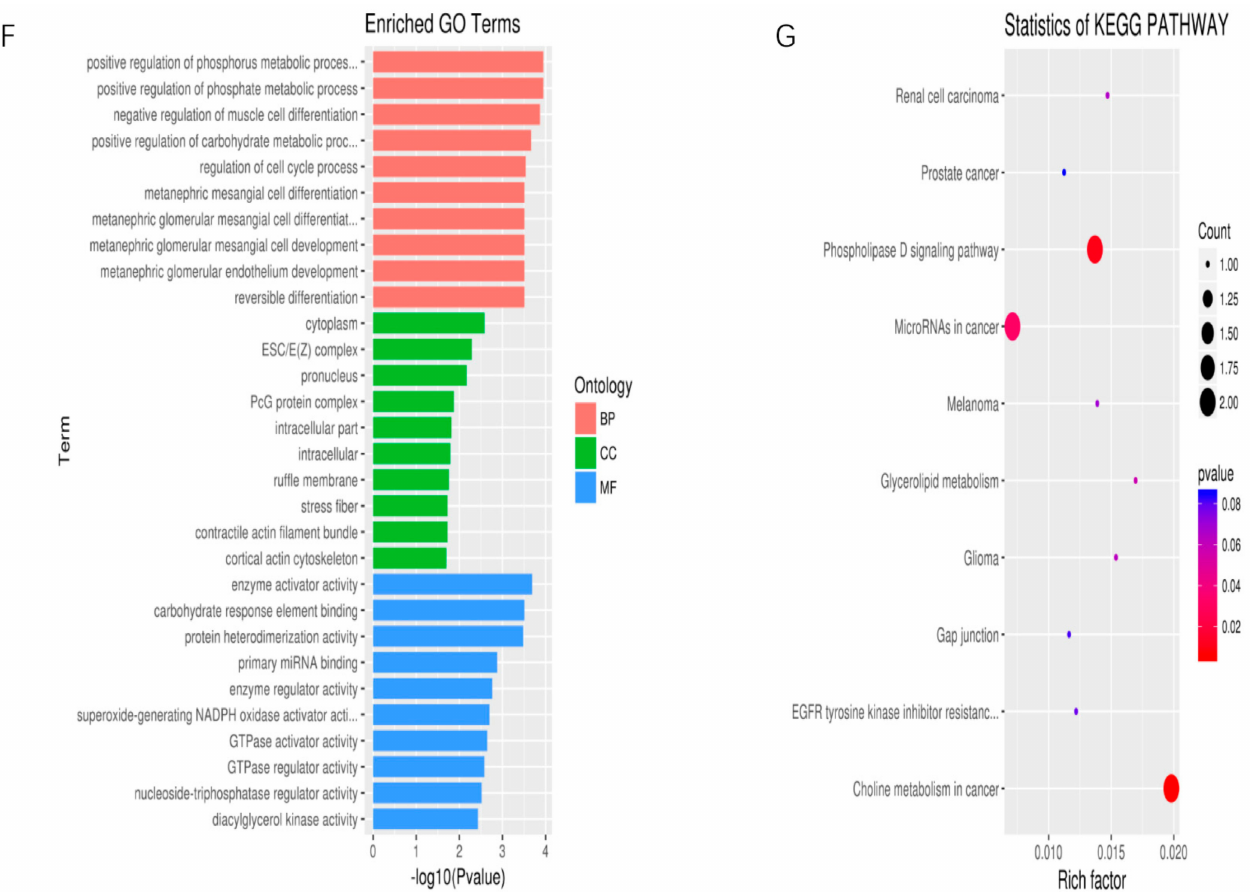
Figure 7. Analysis of circRNA data of neBAT and aBAT. ( A ) Violin plot of circRNA. The circRNA specifically expressed in each tissue was pooled and used in a Violin map. The vioplot shows the abundance on the y-axis. ( B ) Number of specific circRNAs in neBAT and aBAT. ( C ) Venn diagrams of neBAT versus aBAT. ( D ) New circRNAs and known circRNA in circBase. ( E ) Break point location for each circRNA. ( F ) GO categories for host genes of circRNAs. ( G ) KEGG analysis of host genes of circRNAs. Count number and p -value of host genes of circRNAs in